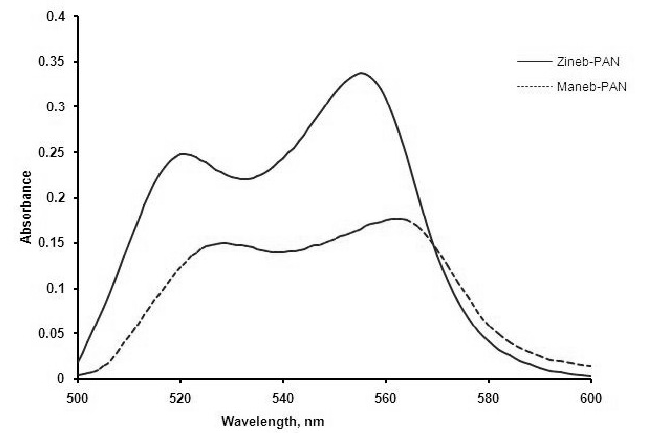
Figure 1. Absorption spectra of 1.326 µg mL -1 Maneb-PAN and 1.378 µg mL -1 Zineb-PAN complexes at pH 9.2 in micellar